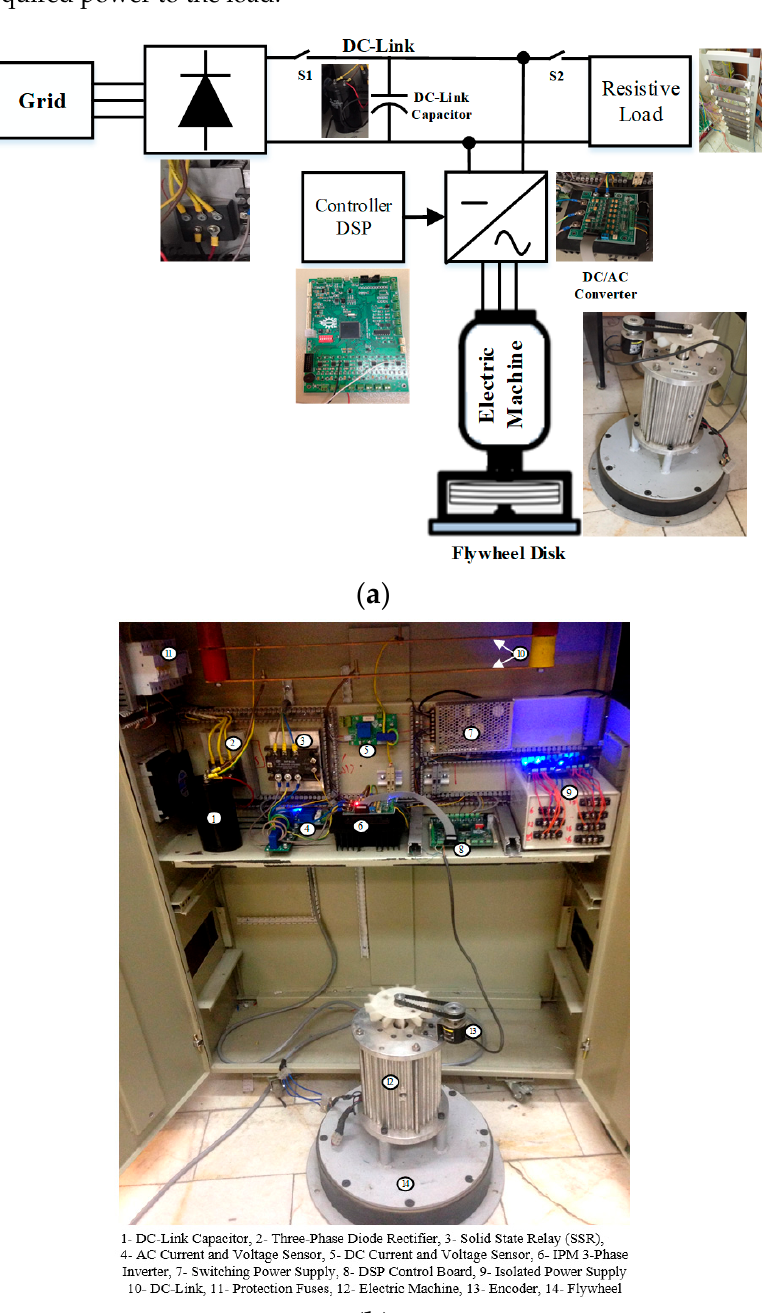
Figure 19. Experimental setup: ( a ) laboratory setup schematic and ( b ) laboratory construction.